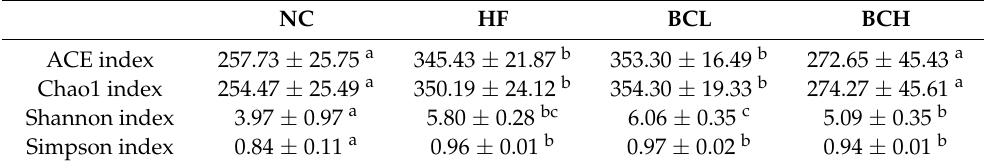
Table 4. The alpha diversity among different